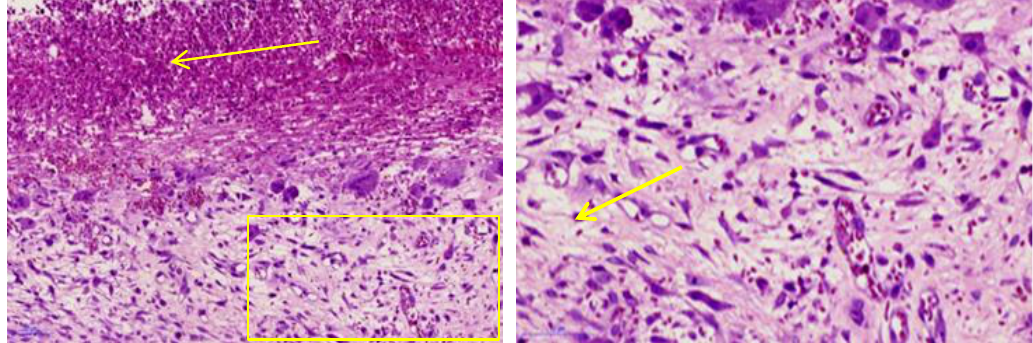
Figure 2: Microphotograph of study group treated with gingival sulcular irrigation of 50 μL/kg of distilled water after one day showing moderate diffuse inflammatory cell infiltration, ulceration of sulcular epithelium (arrows). H&E x20, x40.